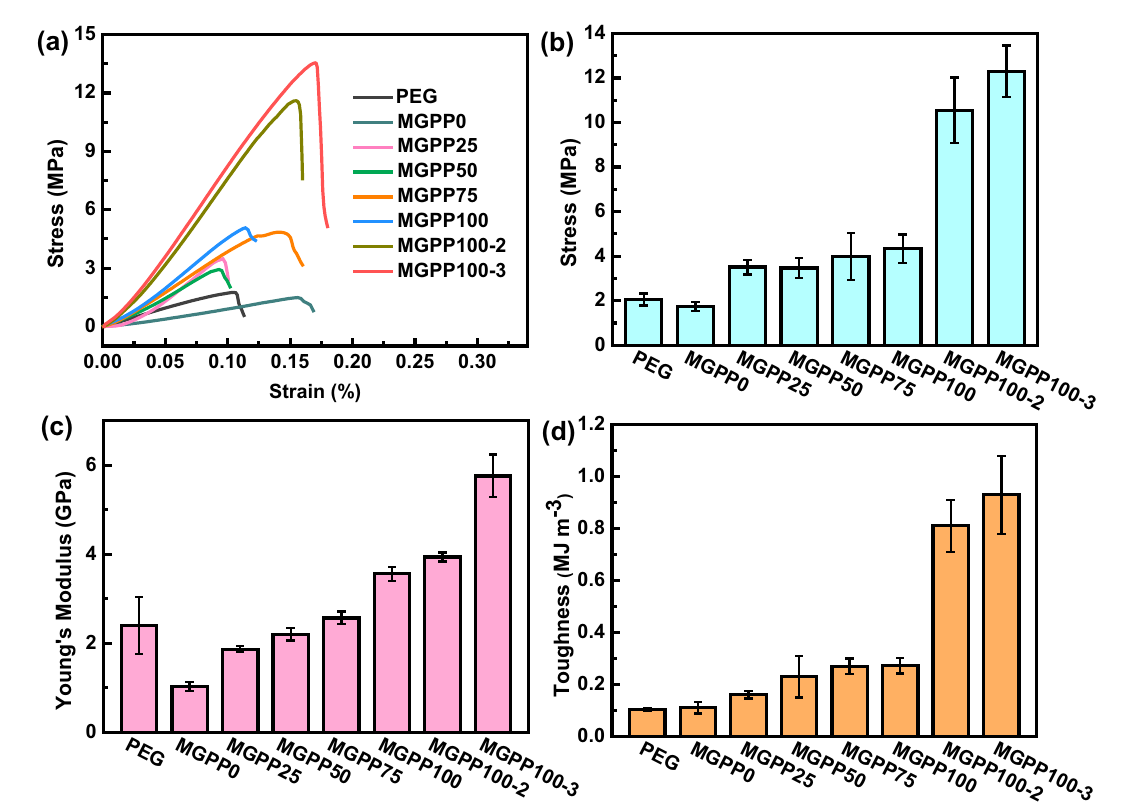
Fig. 8 a Strain–stress curve, b stress, c Young’s modulus, and d toughness of MGPP